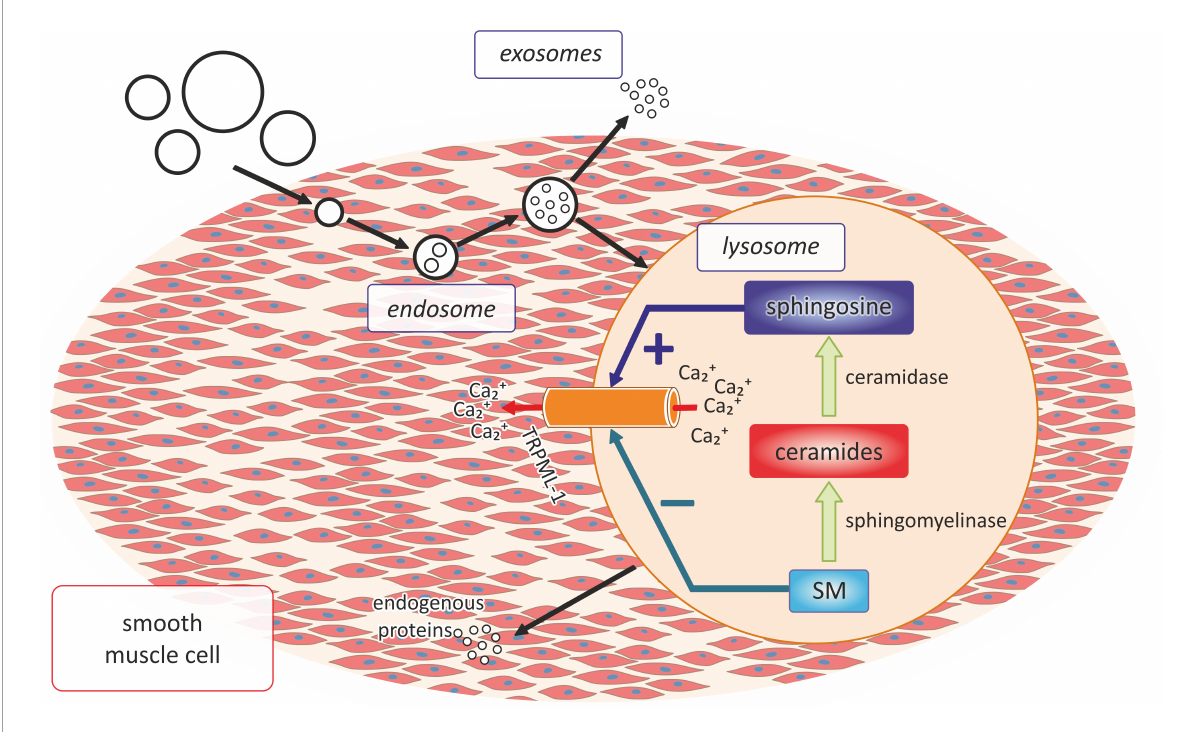
FIGURE3 The role of lysosomal sphingolipid in the process of vascular calcification. SM, sphingomyelin; Ca 2 + , calcium